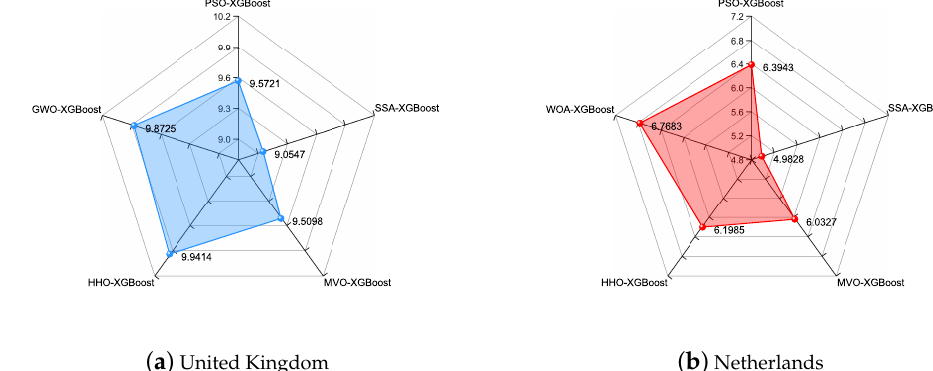
Figure 10. Average MAPEs of the NGC forecasting results.